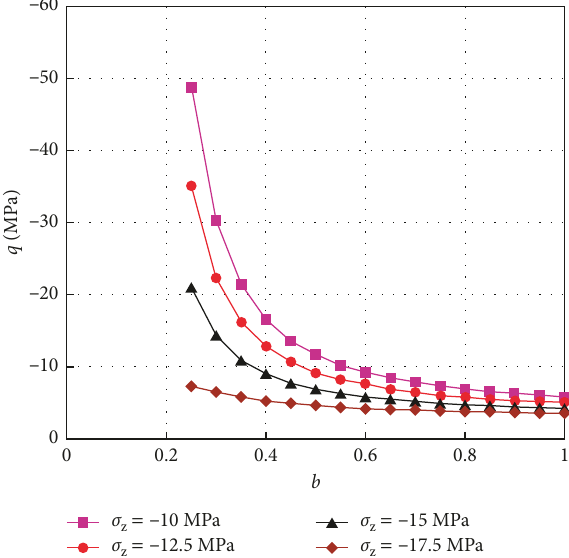
Figure 6: Plastic limit loads of the shaft lining with R sidering the effect of ζ